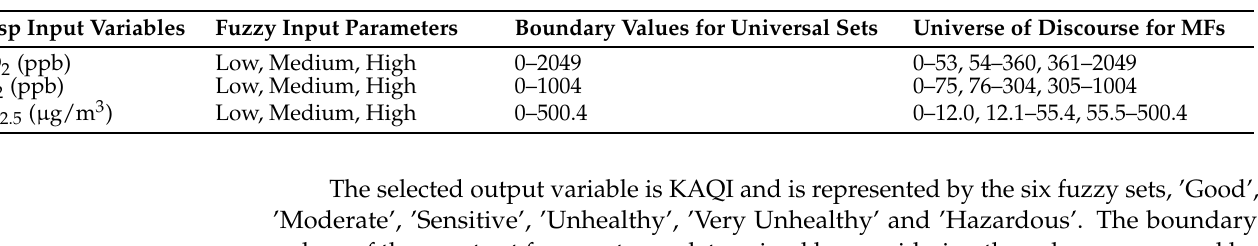
Table 2. The boundary values of crisp sets and fuzzy sets for input parameters, domain ranges, universe of discourse membership function.